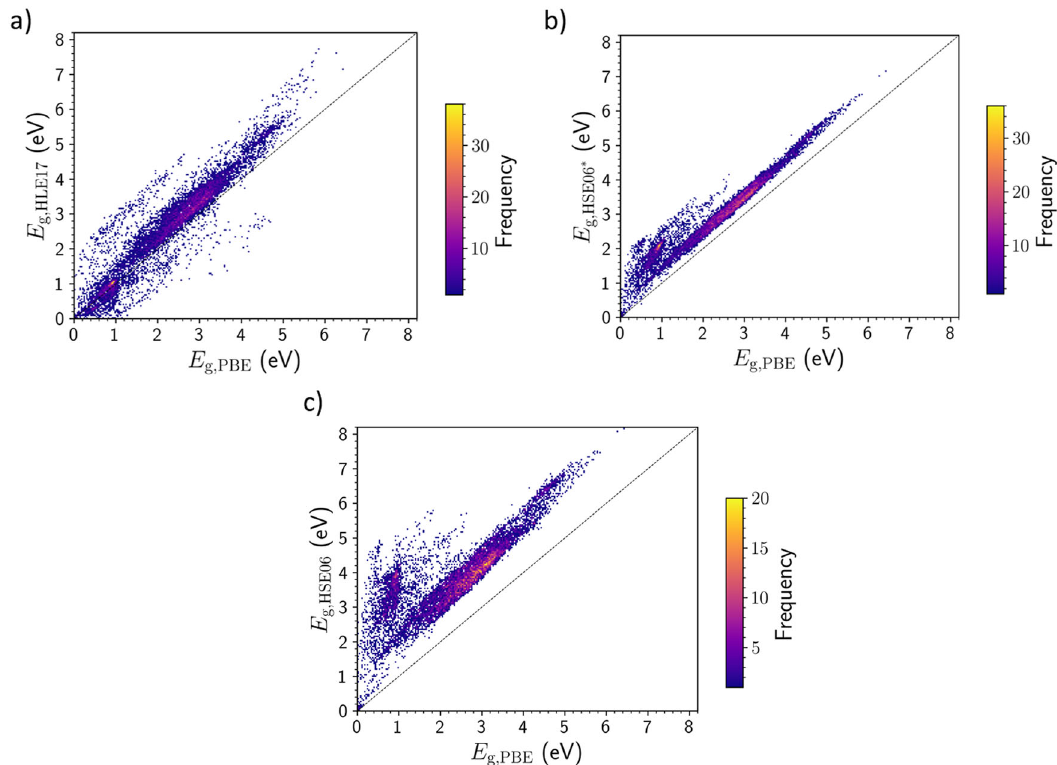
Fig. 3 Correlations between the computed band gaps across multiple levels of theory. Correlation plots of the computed band gaps, E g , for 10,720 structures in the QMOF Database at various levels of theory. a HLE17 vs. PBE; b HSE06 * vs. PBE; c HSE06 vs. PBE. Given the large dataset size, the data is shown as 2D histograms with the color bar re fl ecting the frequency of points in each bin. The y = x line is shown for reference.